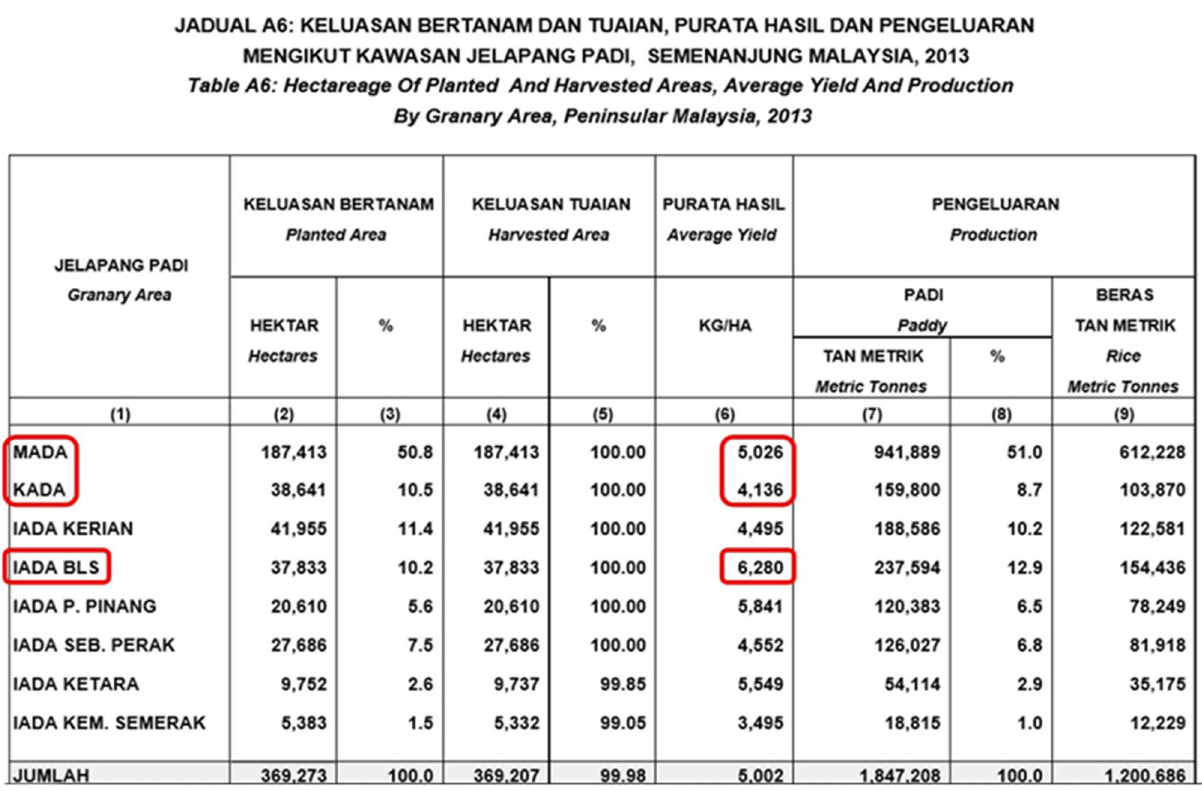
Figure 1. Average yield by granary area in Peninsular Malaysia in 2013.